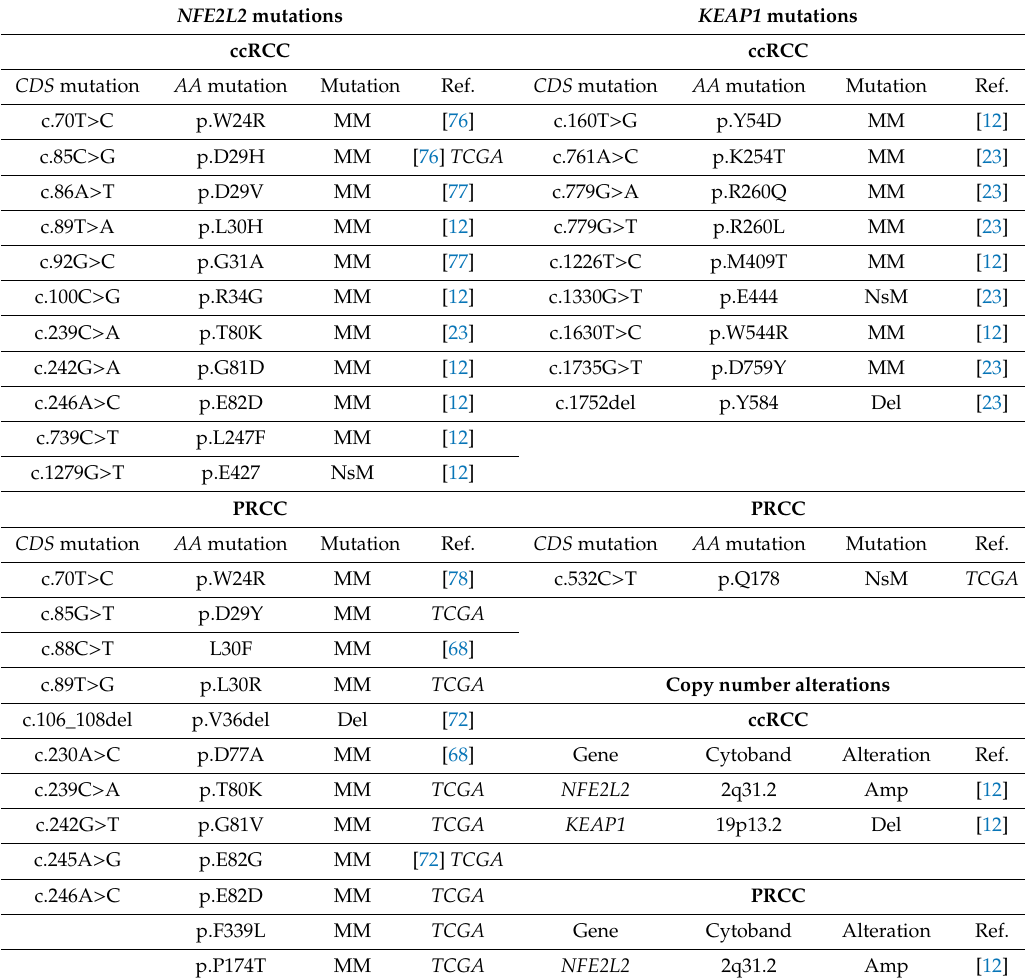
Table 2. NFE2L2 and KEAP1 somatic mutations and copy number alterations identified in human ccRCC and